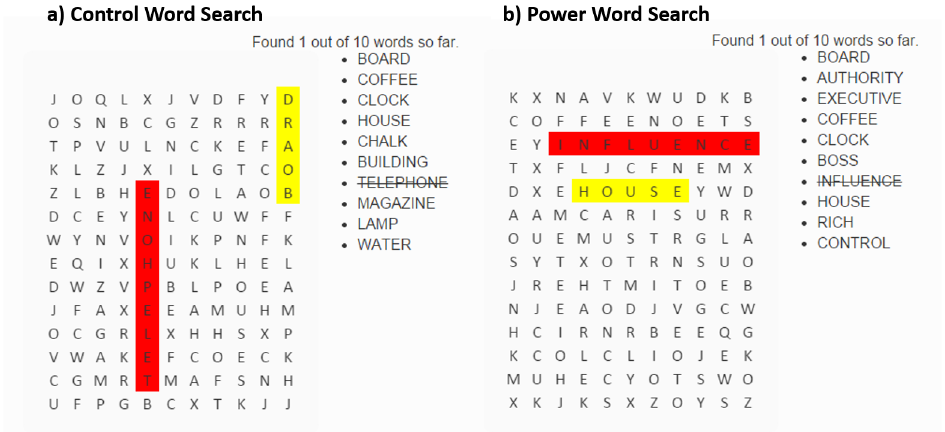
Fig 4. Word Search Manipulation of Power. A) Grid and word list used for the control condition; b) Grid and word list used for the power condition. These are the same grids and lists as used in Gravelin [22]; the task was first introduced by Chen et al. [21]. A demonstration of this task is posted online at: http://tinyurl.com/ word-search-task; source code is posted to the Open Science